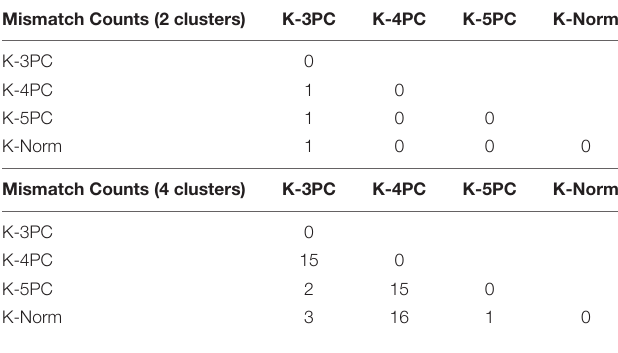
TABLE 1 | Comparison between different clustering